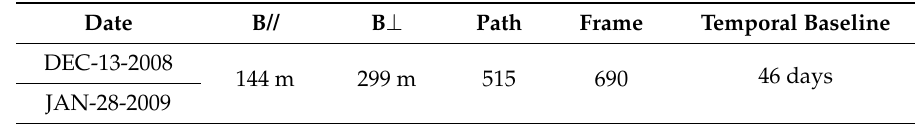
Table 1. Details of the ALOS/PALSAR imagery